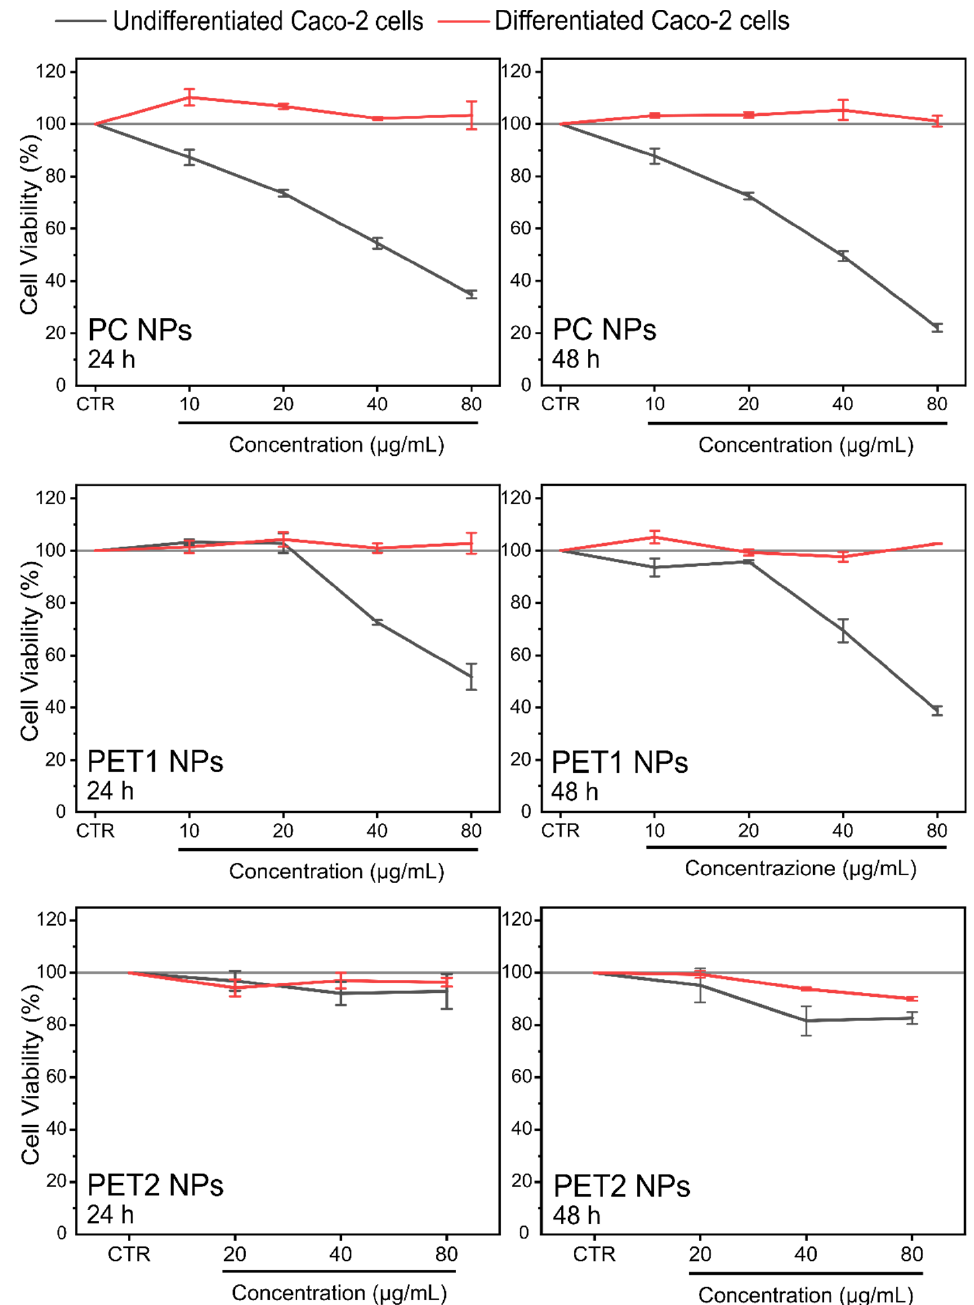
Figure 8. Cell viability of undifferentiated and differentiated Caco-2 cells exposed to different doses of PC, PET1 or PET2 NPs for 24 or 48 h. Data are expressed as percentage of cell viability normalized to the control (untreated cells) and reported as the mean of three independent experiments (each run in triplicate) ± SD.